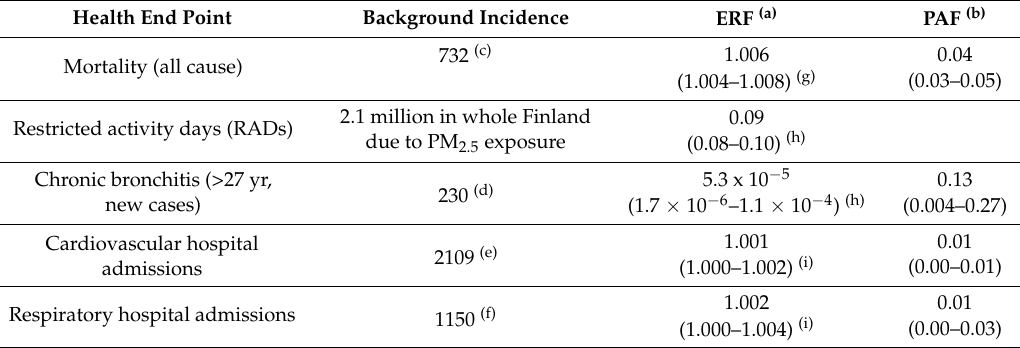
Table 3. Data for the health impact calculations.